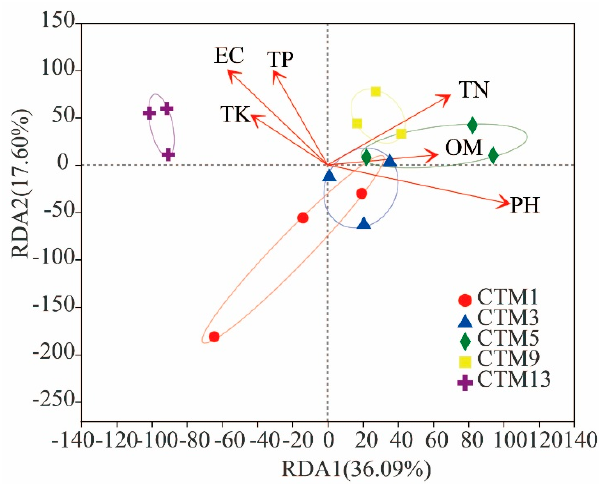
Figure 4. Redundancy analysis (RDA) between soil fungal genus and soil chemical properties among different CTM cycles. TN = soil total nitrogen content; TP = soil total Phosphorus content; TK = soil total potassium content; EC = electrical conductivity; OM = soil organic matter content.